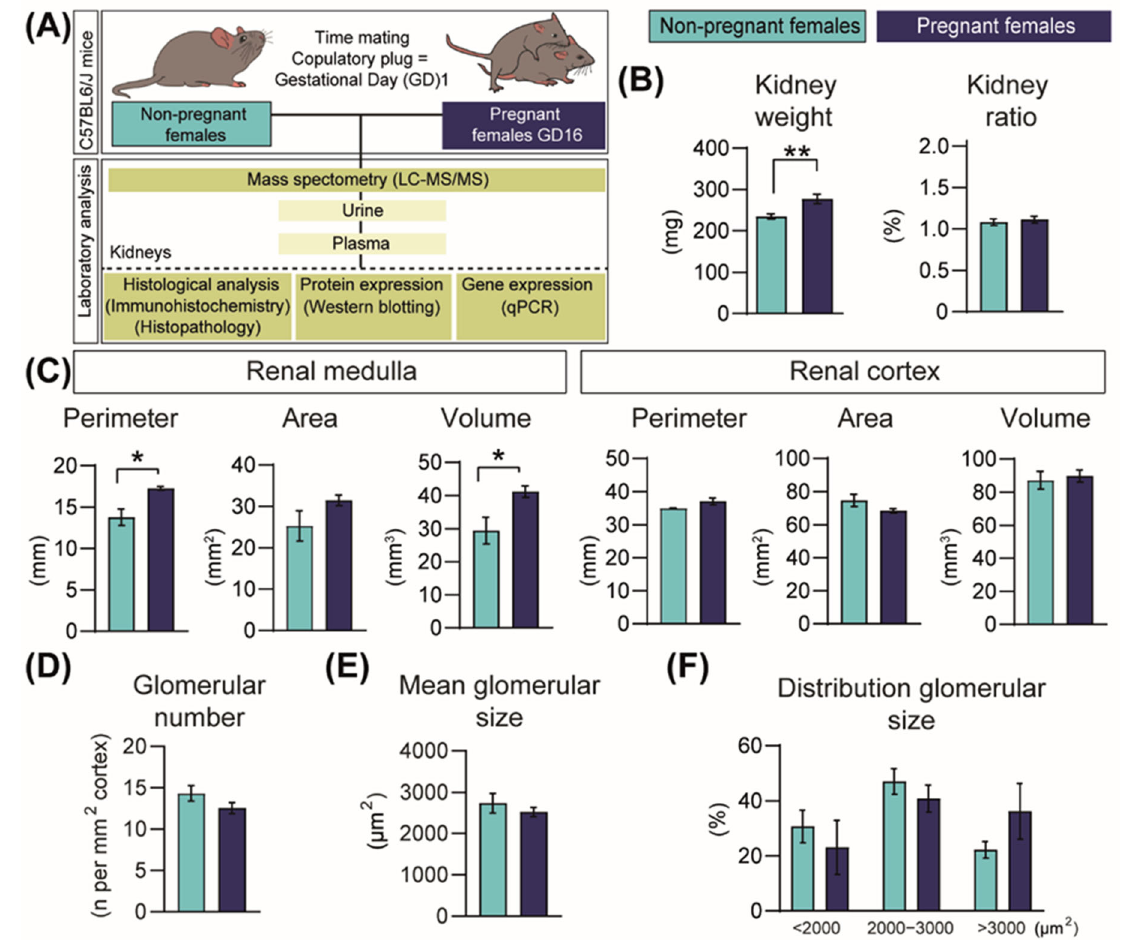
Figure 1. Structural changes in the mouse kidney in response to pregnancy in mice. ( A ) Experimental design. ( B ) Kidney weight and kidney size normalized to hysterectomised weight ( n = 10/group). ( C ) Renal medulla and cortex sizes ( n = 4–5/group). ( D , F ) Glomerular number and glomerular size in the renal cortex ( n = 5/group). All data are presented as mean ± SEM and were analysed by unpaired Student t -test or Mann–Whitney U Test. Asterisks represent significant difference between non ‐ pregnant and pregnant mice (* p < 0.05; ** p < 0.01).